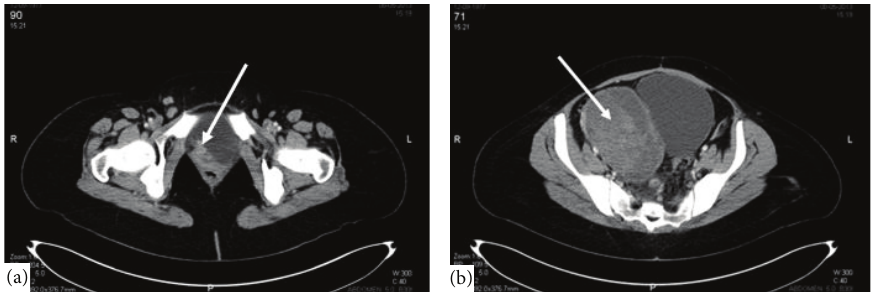
Figure 1: Cervical mass invading bladder (a) and right adnexal heterogeneous mass (b) on computerized tomography.